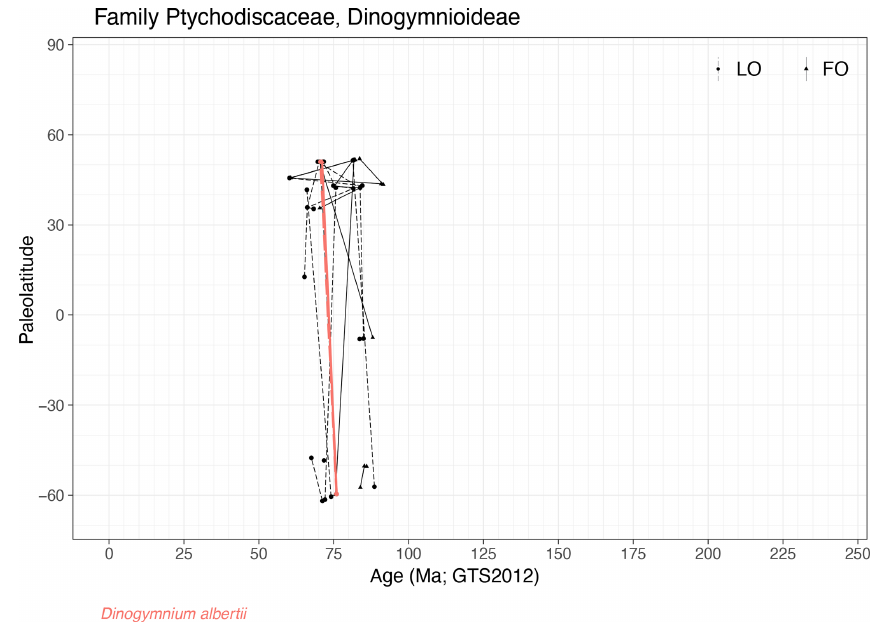
Figure 27. Same as Fig. 5 but for the family Ptychodiscaceae, subfamily Dinogymnioideae.